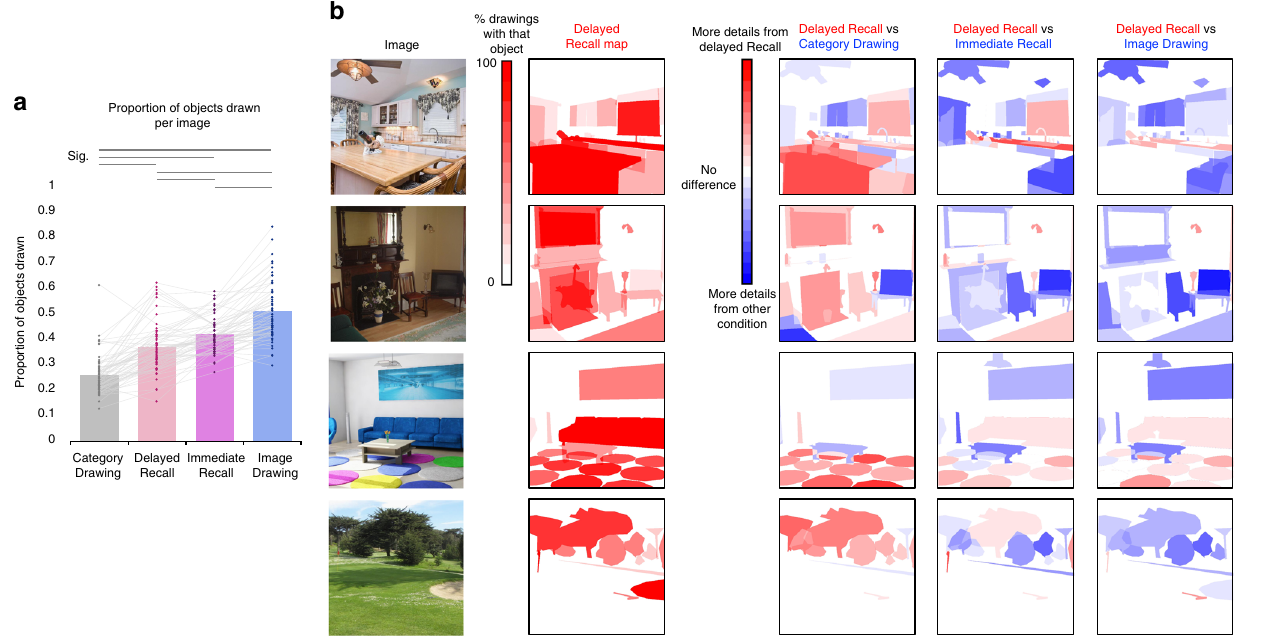
Fig. 2 Comparison of objects drawn across conditions. a Average proportion of objects drawn for each drawing condition (Category Drawing, Delayed Recall, Immediate Recall, Image Drawing). Dots indicate average proportion for each of the 60 images used in the experiment, with lines connecting the same image across conditions. Horizontal lines above the graph indicate signi fi cant pairwise Wilcoxon rank-sum test comparisons that pass a Bonferroni- corrected signi fi cance level of p < 0.0083. b Example heatmaps of which objects were remembered. The “ Delayed Recall Map ” shows the drawing frequency of each object in the Delayed Recall drawings. Bright red indicates objects remembered by all participants who drew the image, and white indicates objects that were not remembered by anyone (white also indicates the background). The heatmaps on the right indicate the difference between the Delayed Recall heatmap (red) and the corresponding heatmaps for Category Drawing, Immediate Recall, and Image Drawing (blue), where white is a neutral color (background and objects that were drawn with equal frequency in both conditions). There were generally more objects in Image Drawings